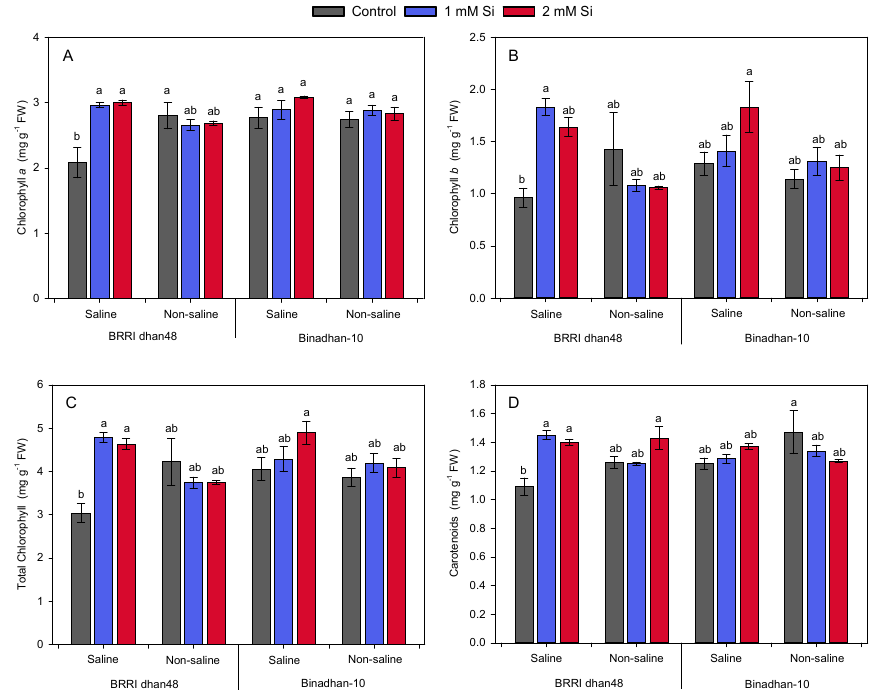
Figure 3. Effect of exogenous Si (1 and 2 mM silicic acid) on rice plants subjected to salt stress (10 dSm − 1 ). ( A ) Chlorophyll a , ( B ) chlorophyll b , ( C ) total chlorophylls and ( D ) carotenoids were recorded in the leaves of two contrasting rice cultivars after six days of recovery from salt stress. Different letters above the bars indicate significant differences among the treatments following Tukey’s HSD